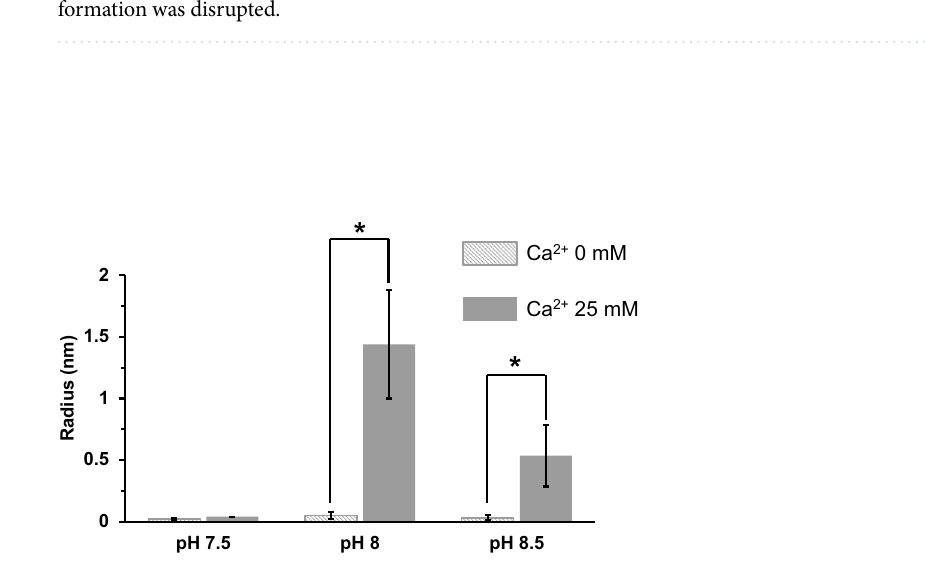
Figure 5. A particle size of the rMERP measured using dynamic light scattering (DLS). The aggregation activity of rMERP in the absence or presence of calcium ion at pH 7.5, 8.0 and 8.5 was measured. Data are expressed as the mean ± S.E. Statistically significant differences were determined by t-test (* p < 0.05, n =